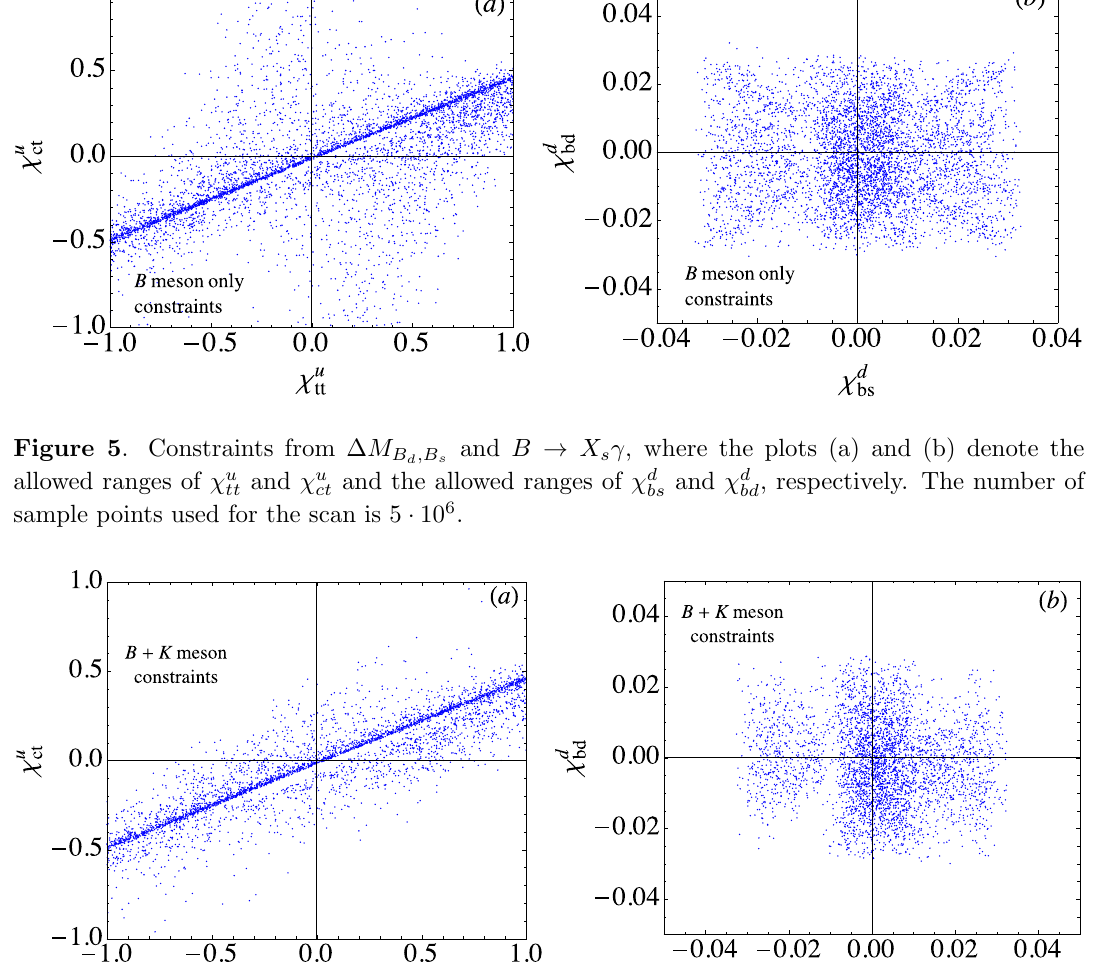
Figure 6 . Based on the results in (cid:12)gure 5, the constraints from the H (cid:6) -induced (cid:1) M K and (cid:15) K are